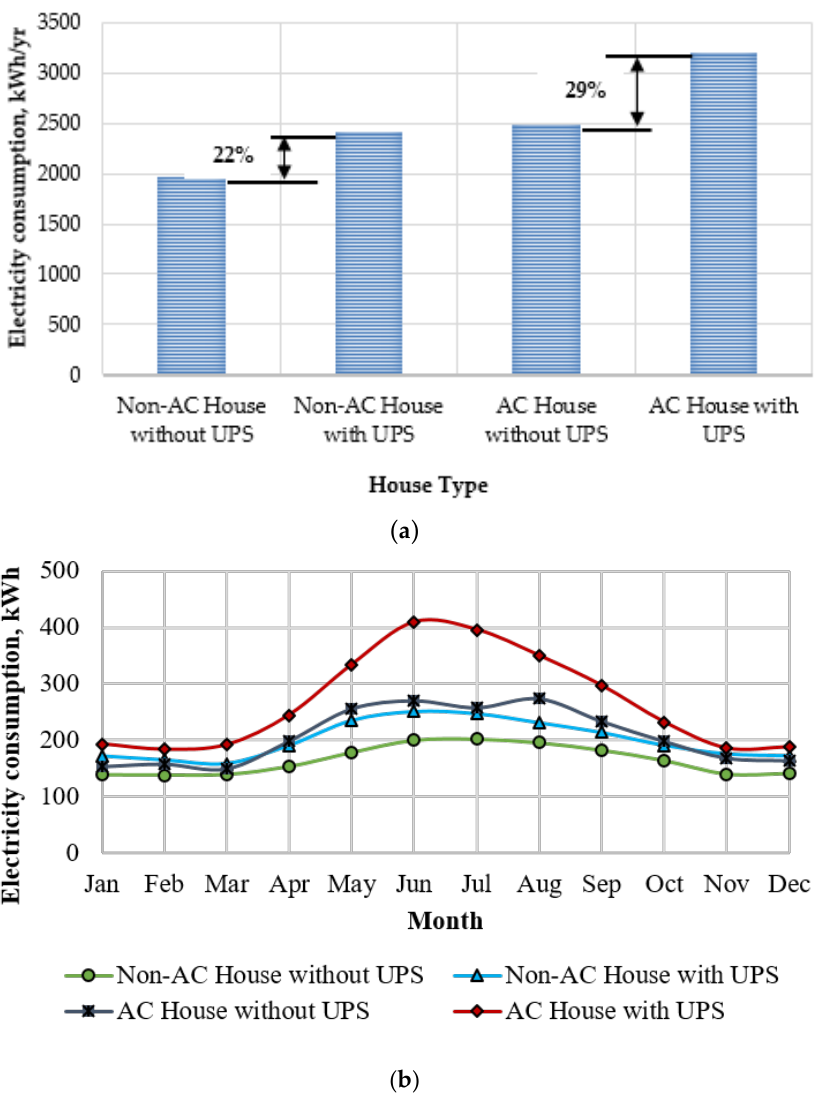
Figure 10. ( a ) Y early electricity consumption of AC and non-AC houses with and without UPS. ( b ) Monthly electricity Figure 10. ( a ) Yearly electricity consumption of AC and non-AC houses with and without consumption of AC and non-AC houses with and without UPS.